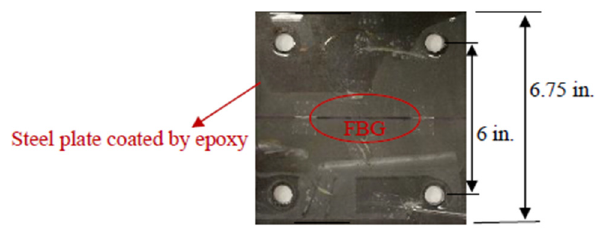
Figure 5. An example embedded FBG sensor. Table 1. Properties of the FBG sensors.